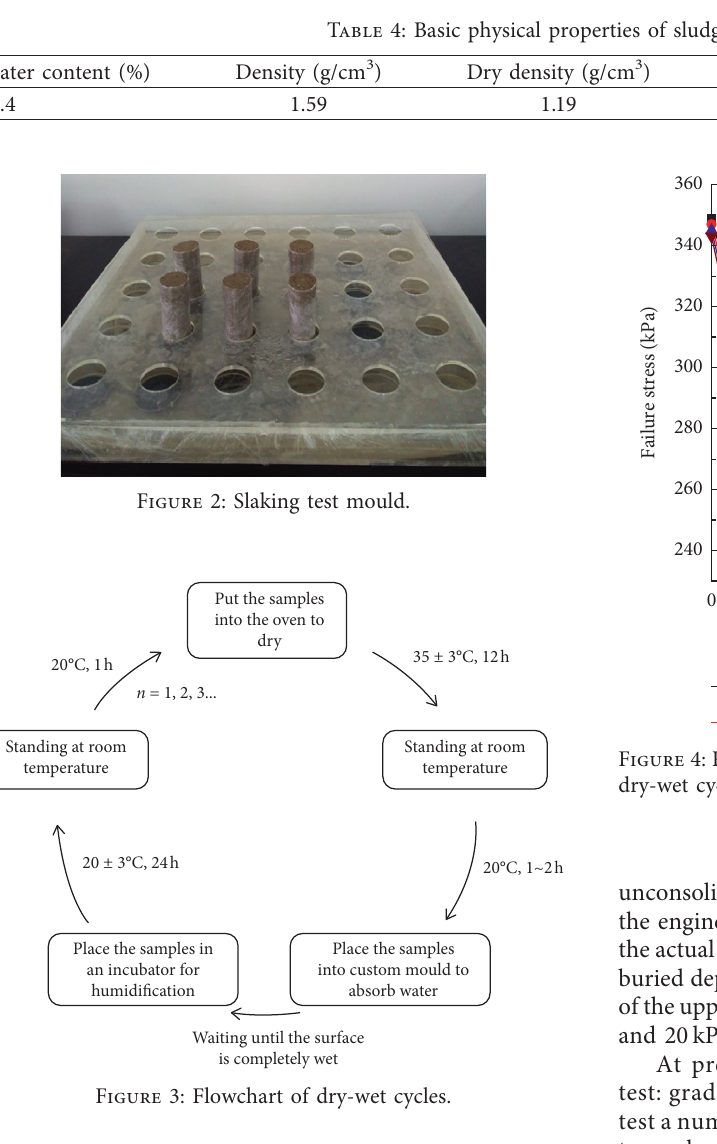
Figure 3: Flowchart of dry-wet cycles.